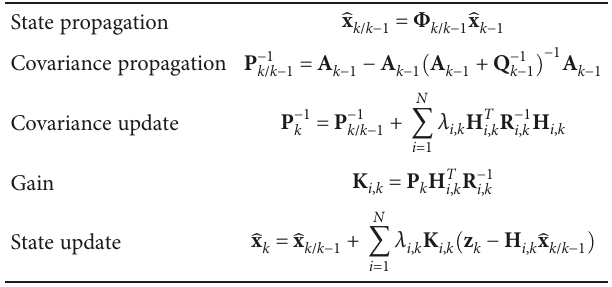
Table 1: Information fi lter with intermittent